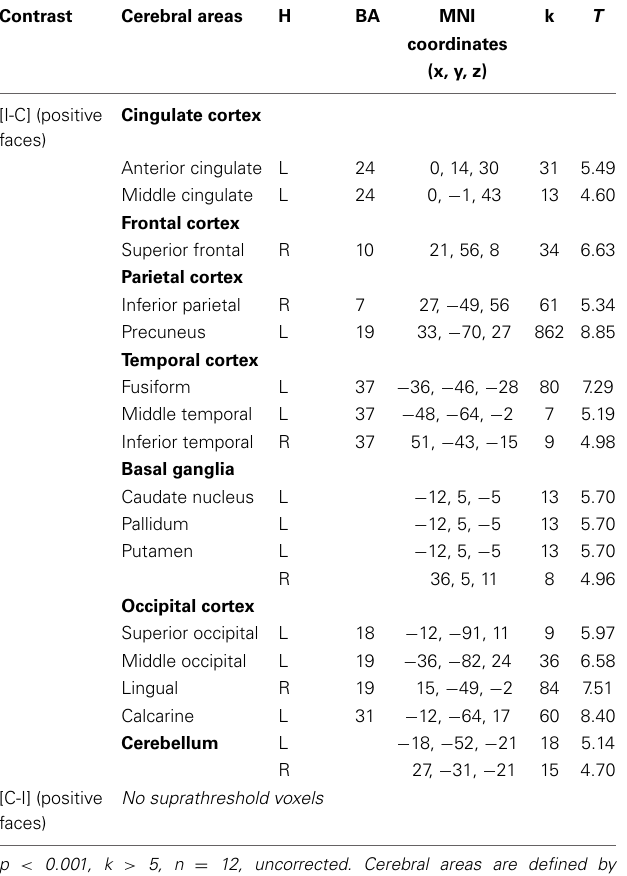
Table 6 | Brain regions activated during the emotional Stroop task with negative faces in drug-off patients.